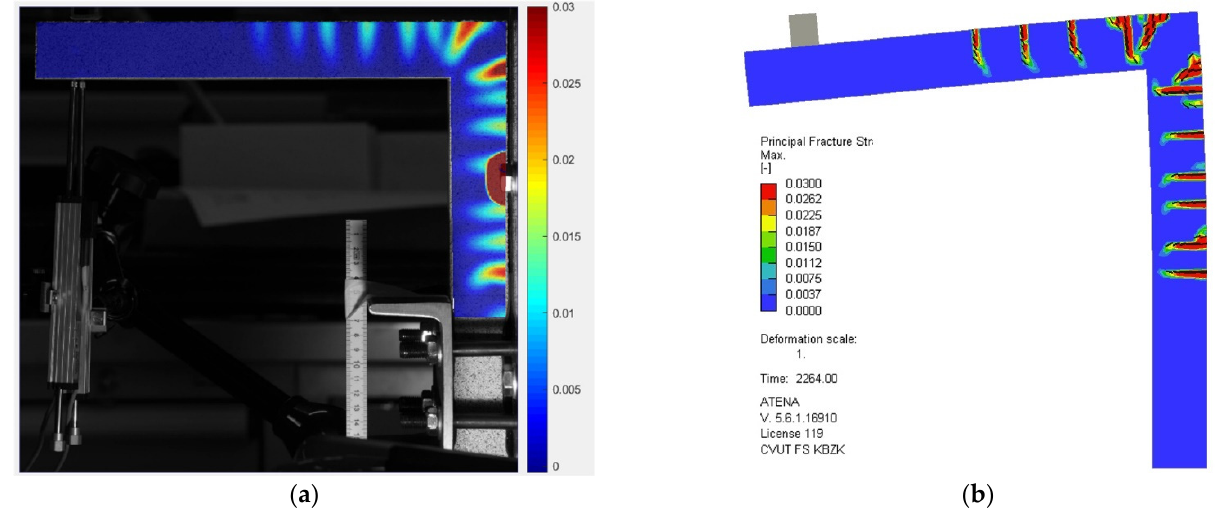
Figure 16. Comparison of the crack development and opening during the closing of the rigid frame. Principal strain of the experimental setup as captured by the DIC ( a ) and image depicting numerical strain predicted by the numerical analysis ( b ).